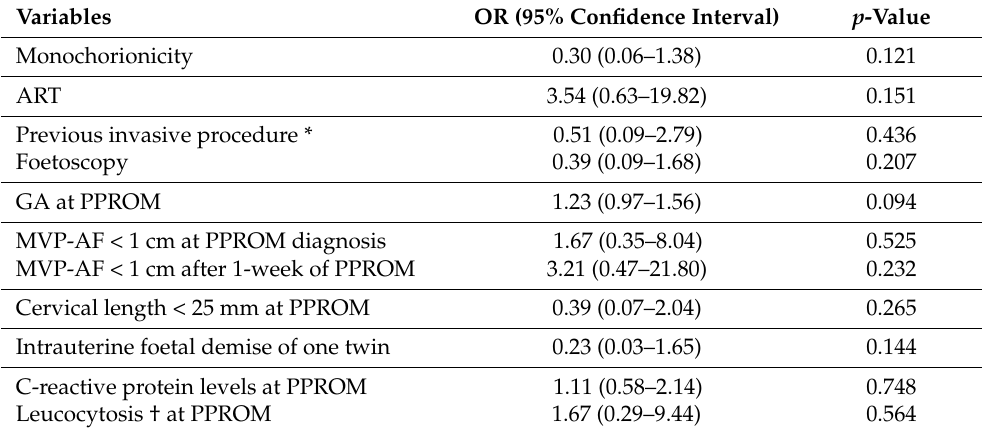
Table 4. Univariate analysis of factors associated with delivery ≥ 23 + 0